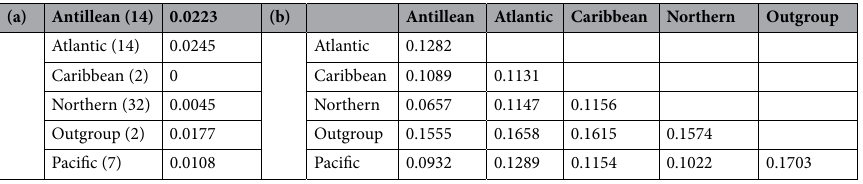
Table 2. Estimates of average evolutionary divergence over sequence pairs (a) within and (b) between groups (genetic